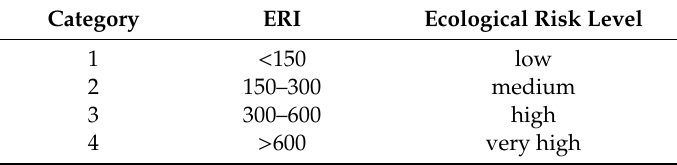
Table 2. Classification system for ecological risk of the mangrove soils based on ecological risk index. Category ERI Ecological Risk Level 1